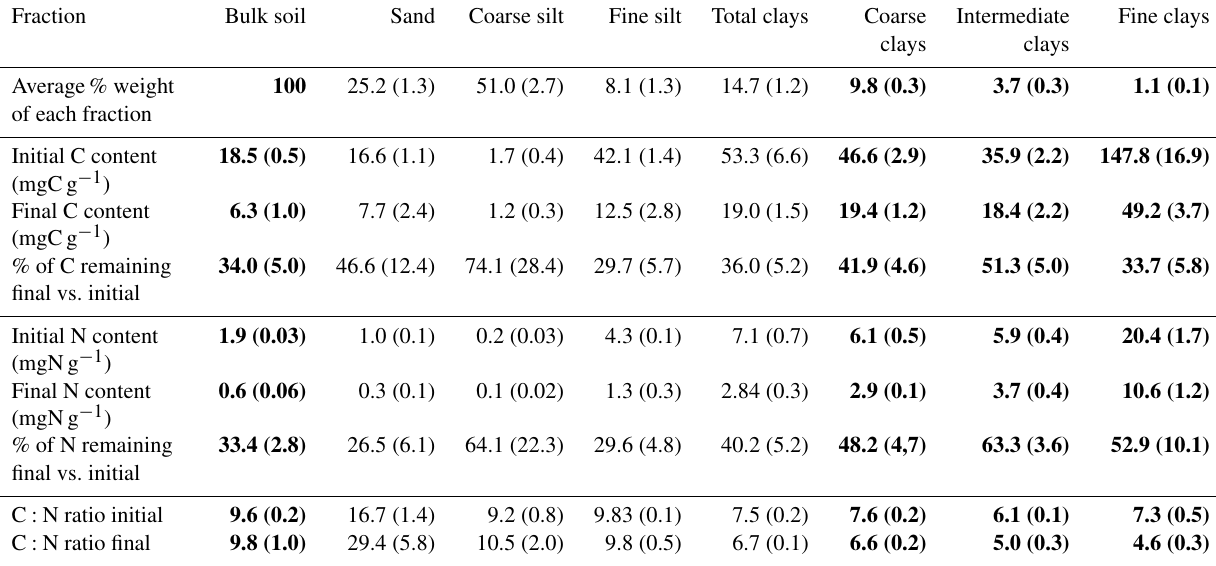
Table 1. Carbon and nitrogen contents and corresponding losses of organic carbon and nitrogen in each of the fractions on the first and last sampling dates. Standard deviations are indicated in parentheses. Data for bulk soil and for clay fractions are in bold as they will be discussed in length throughout the paper.